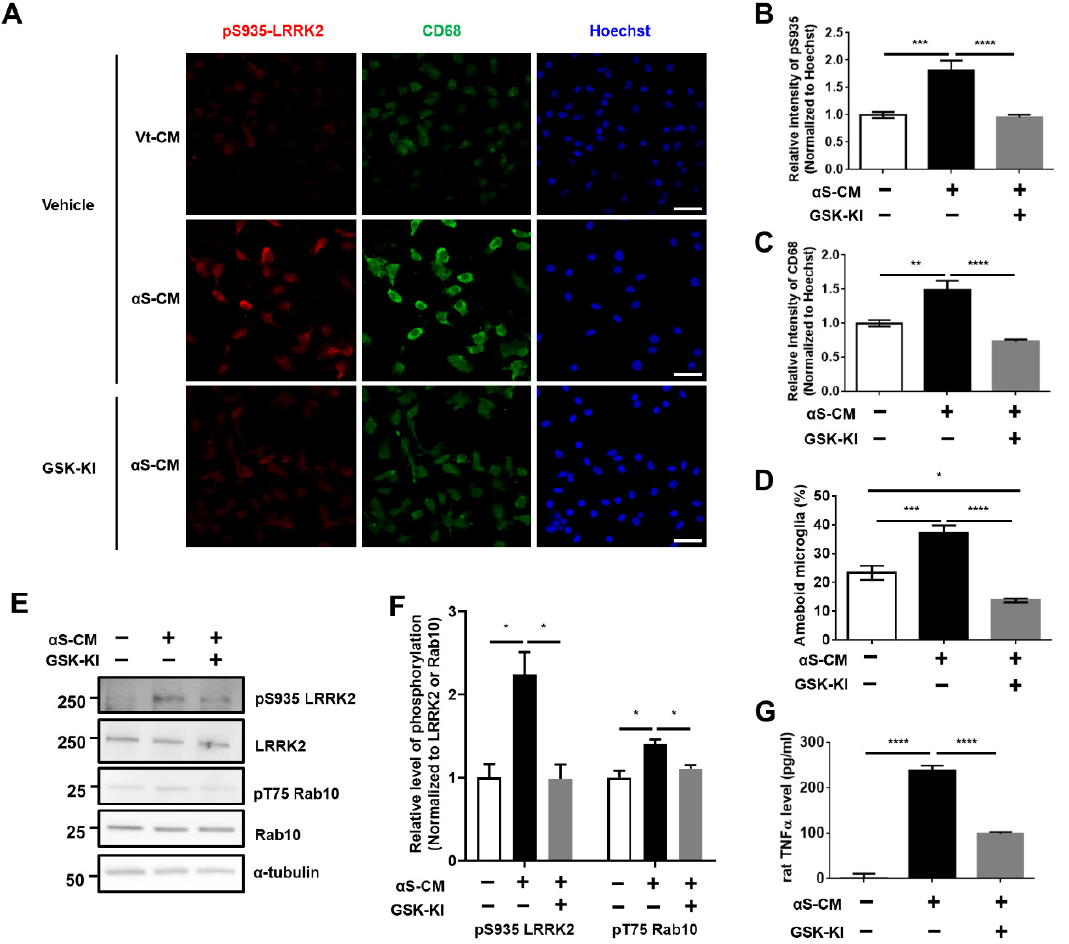
Figure 3. LRRK2 inhibitor ameliorated α Syn-induced neuroinflammation in rat primary microglia. ( A – C ) Immunostaining of pS935 and CD68, as markers of microglial activation, was assessed using their fluorescence intensities, and the microglia with ameboid morphology were counted ( D ). n = 3, approximately 30–60 cells for IF. ( E , F ) The change in LRRK2 activity induced by the treatment of α S-CM with or without GSK-KI was analyzed using Western blotting, and the released levels of rat TNF α from ( E ) were determined using ELISA ( G ). n = 3. * p < 0.05, ** p < 0.01, *** p < 0.001, and **** p < 0.0001. All data are represented as the mean ± SEM. Phosphorylation levels of the LRRK2 substrate Rab10 (pT75 Rab10), which serves as